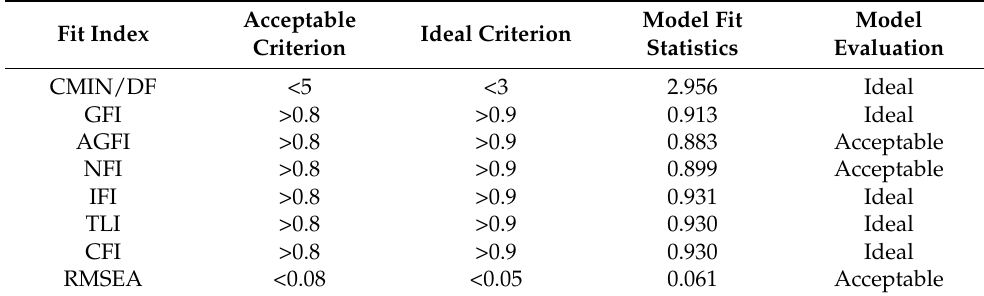
Table A4. CFA fit indices of built environment measurement